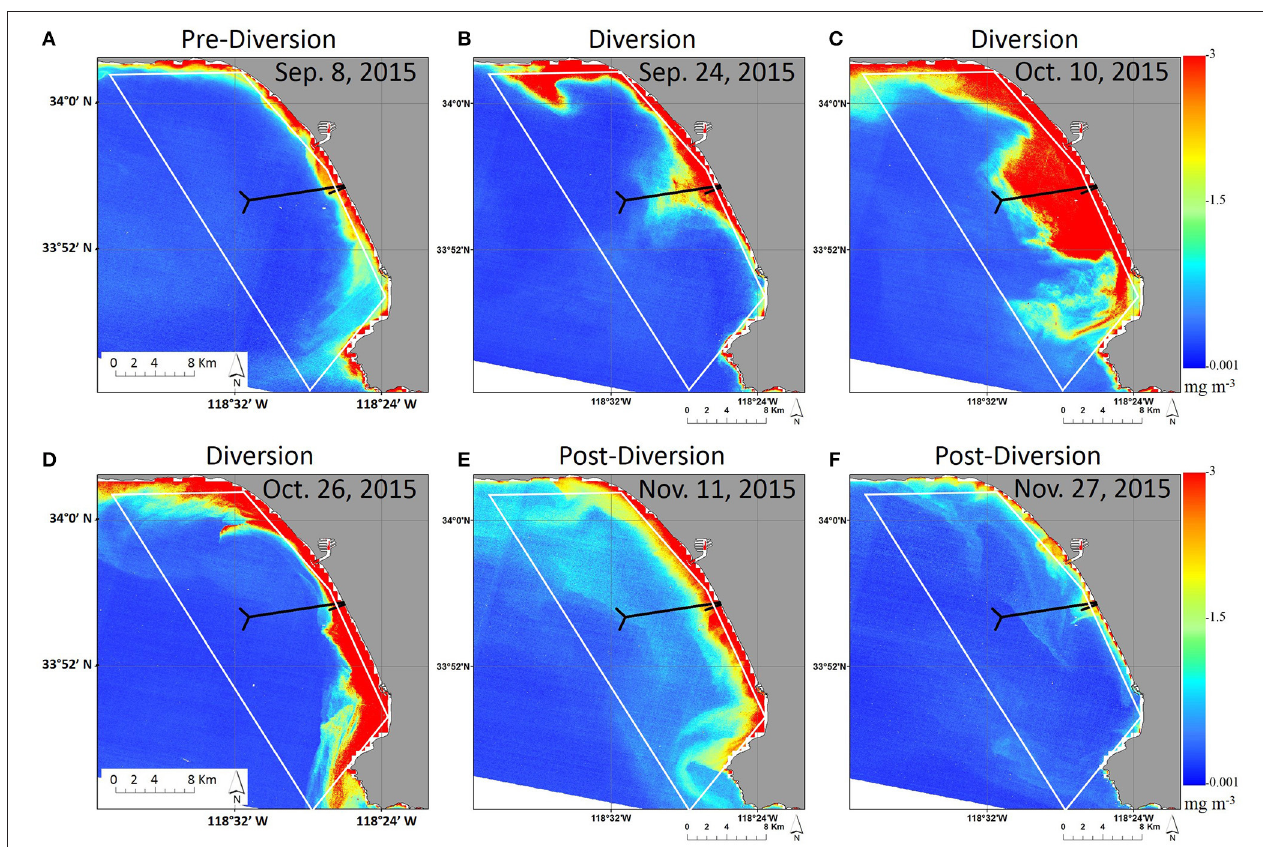
FIGURE 7 | Time series of chl-a in Santa Monica Bay using the local OLI algorithm. The white box denotes a coastal region of interest most affected by changes in chl-a , analyzed in Figure 9 . (A) 8 September 2015, pre-diversion; (B) 24 September 2015, 3 days into the diversion; (C) 10 October 2015, 19 days into the diversion; (D) 26 October 2015, 35 days into the diversion; (E) 11 November 2015, 9 days post-diversion; (F) 27 November 2015, 25 days post-diversion. During the diversion, elevated chl-a levels were detected in the vicinity of the 1-mile outfall pipe, extending offshore, and along the coastline. Values returned to nominal levels post-diversion.